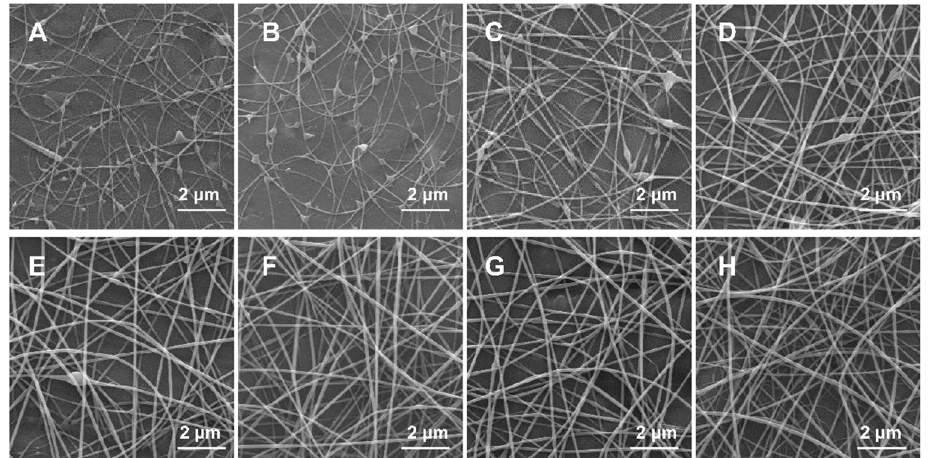
Figure 3. SEM images of electrospun fibers obtained from GG solutions with concentration of: ( A ) 1.1 wt %; ( B ) 1.3 wt %; ( C ) 1.5 wt %; ( D ) 1.7 wt %; ( E ) 1.9 wt %; ( F ) 2.0 wt %; ( G ) 2.1 wt %; and ( H ) 2.2 wt %. Magnification is 10,000×.